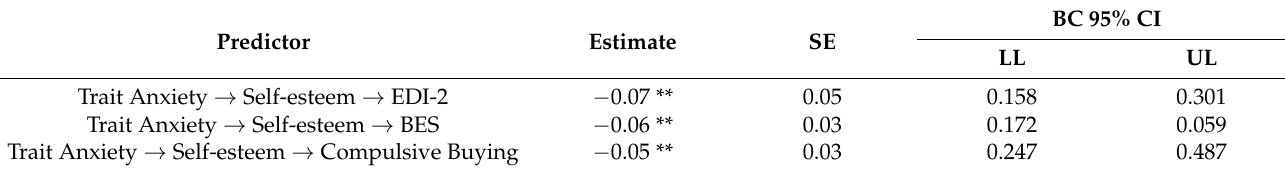
Table 2. Standardized indirect